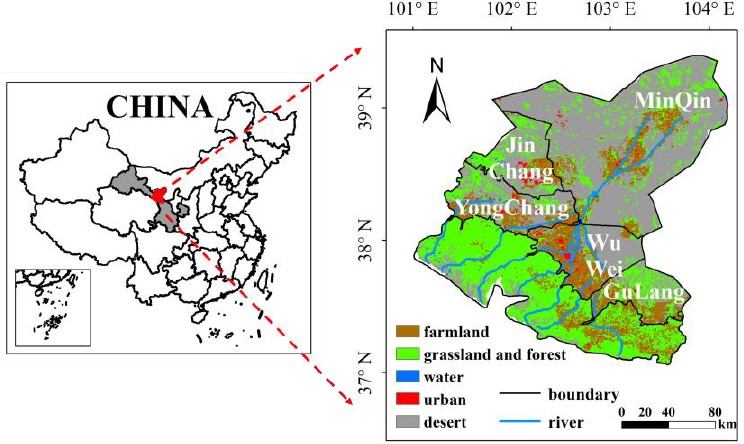
Figure 1. Geographical location of the Shiyang River Basin (HRB) in Gansu Province, China, and the distribution of land use and riverways within the Basin.